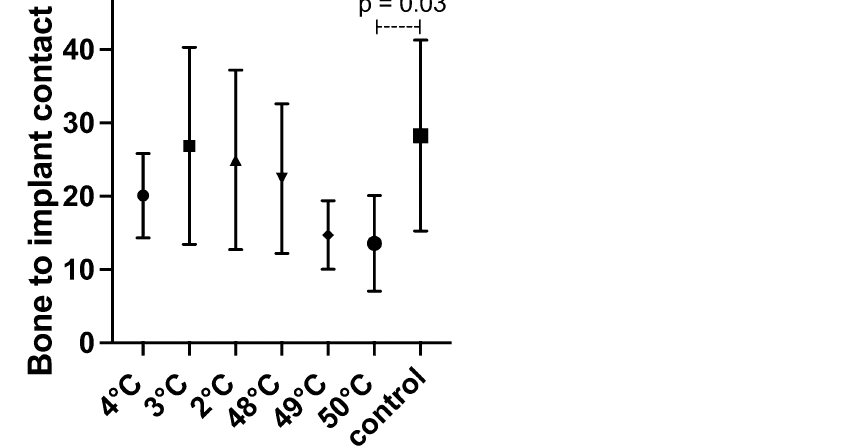
Figure 3. The bone-to-implant ratio (BIC) was calculated by measuring (μm) the complete circumference in the sectioning of the implant and then recording the area with histologic bone